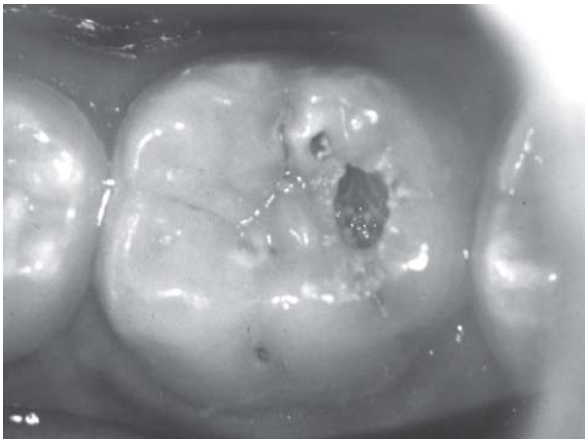
Figure 4- Control after